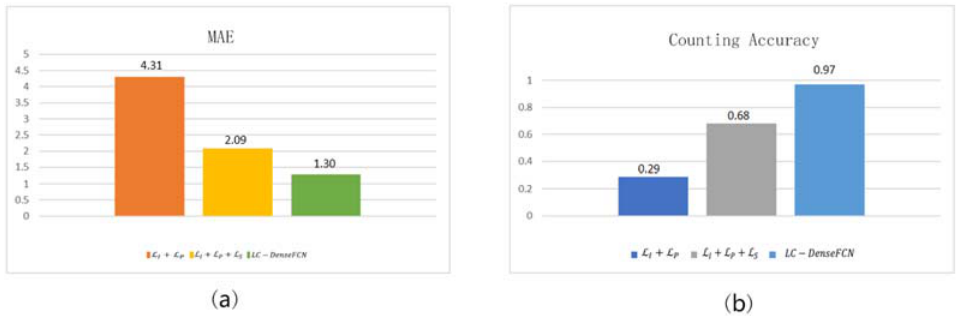
Figure 5. Comparison of different parts of the proposed loss function for counting and localization performance. ( a ) The mean absolute error (MAE) performance of the three loss functions. ( b ) The counting accuracy of the three loss functions.